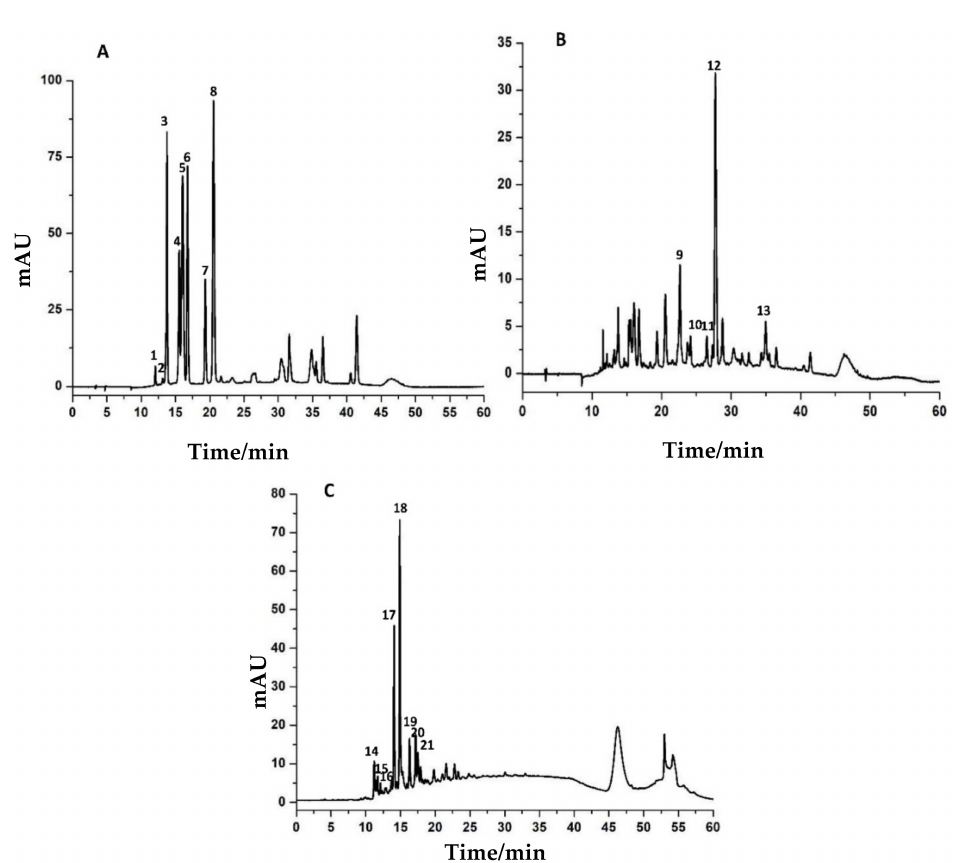
Figure 1. Typical HPLC profile of a Regent skin extract. Chromatograms were recorded at ( A ) λ = 518 nm, ( B ) λ = 360 nm, and ( C ) λ ex = 225 nm and λ em = 320 nm. 1. delphinidin-3,5- O -diglucoside; 2. cyanidin- 3,5- O -diglucoside; 3. delphinidin-3- O -glucoside; 4. peonidin-3,5- O -diglucoside; 5. malvidin-3,5- O -diglucoside; 6. cyanidin-3- O -glucoside; 7. peonidin-3- O -glucoside; 8. malvidin-3- O